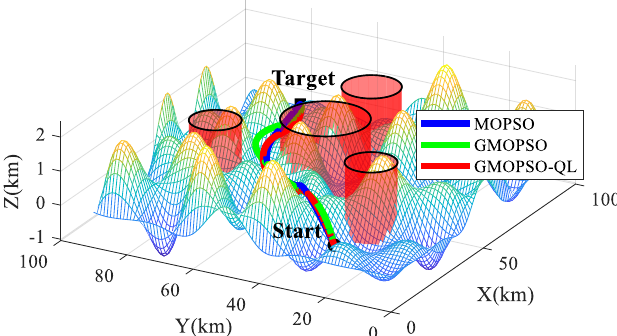
Figure 9. 3D view of the best flight paths in Case 2.